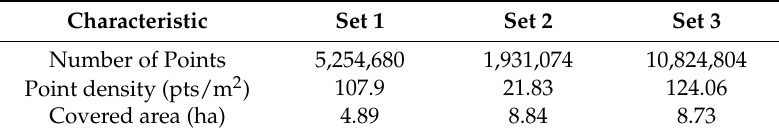
Table 1. Point cloud characteristics for each dataset. 128